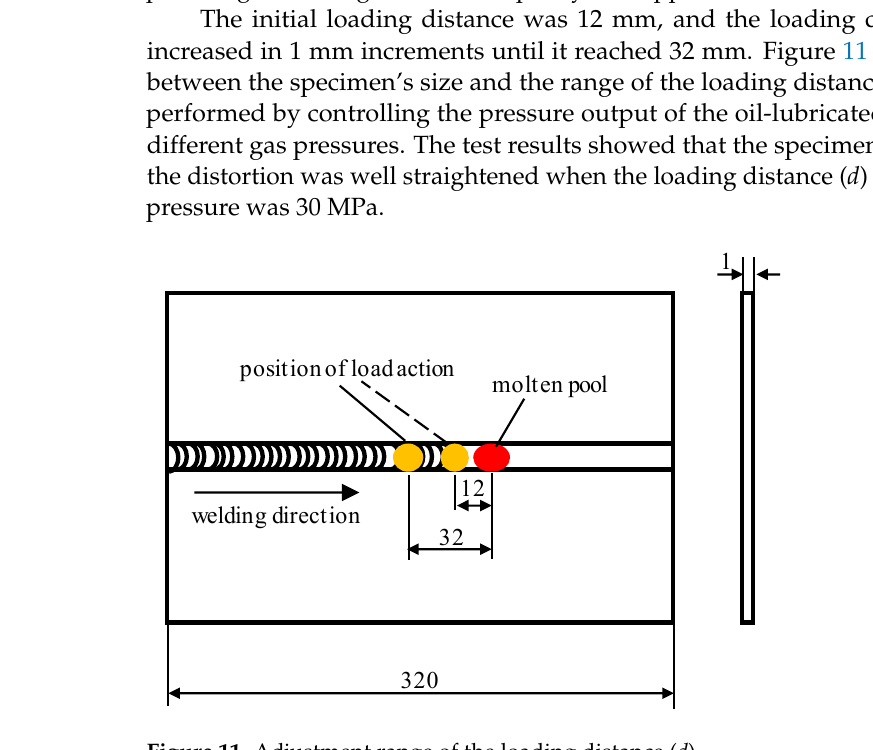
( b ) Figure 12. Test images of the strip cutting method: ( a ) before cutting; ( b ) after cutting.